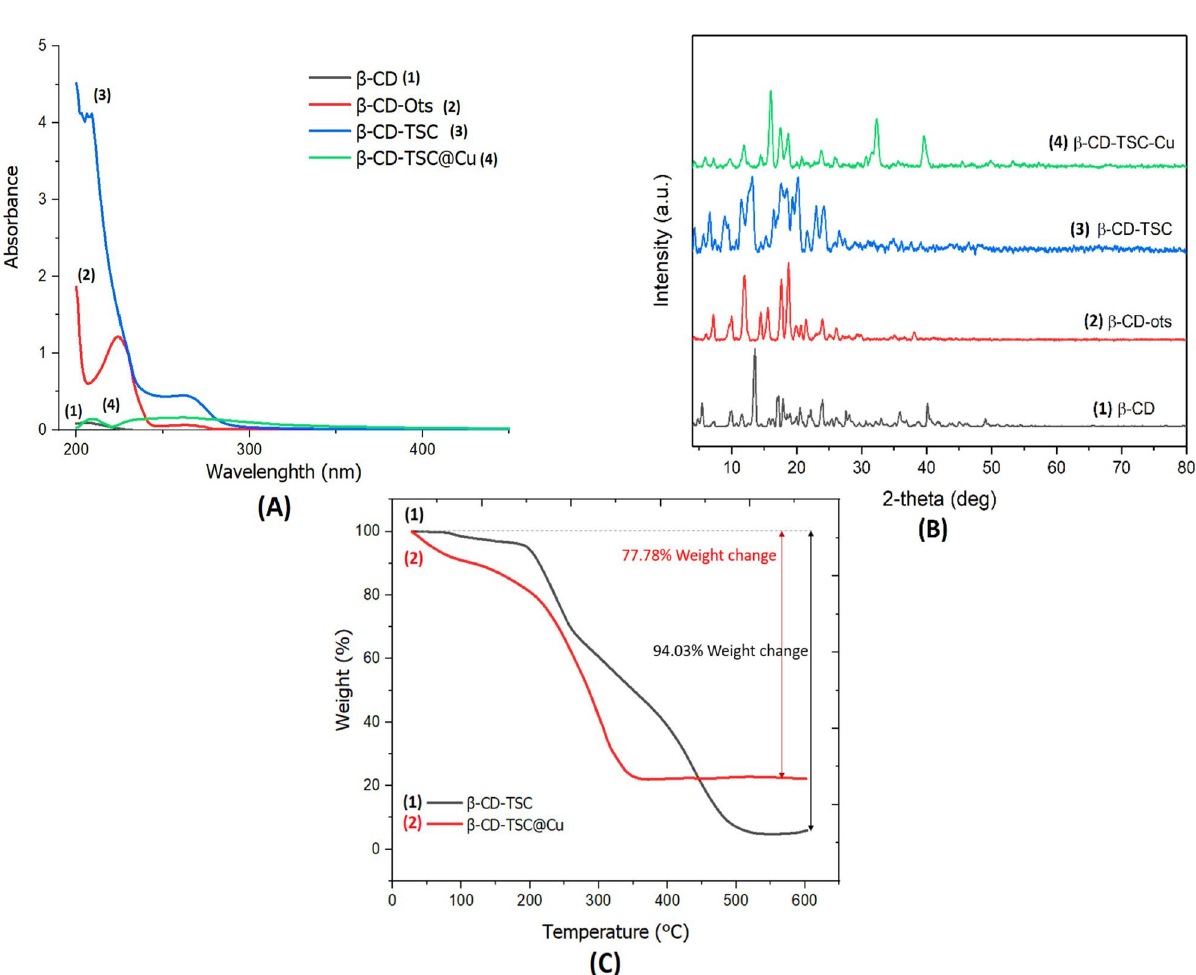
Figure 5. ( A ): UV–Vis spectrum, ( B ): XRD patterns, ( C ): TGA curves recorded in the air at a heating rate of 10 °C min −1